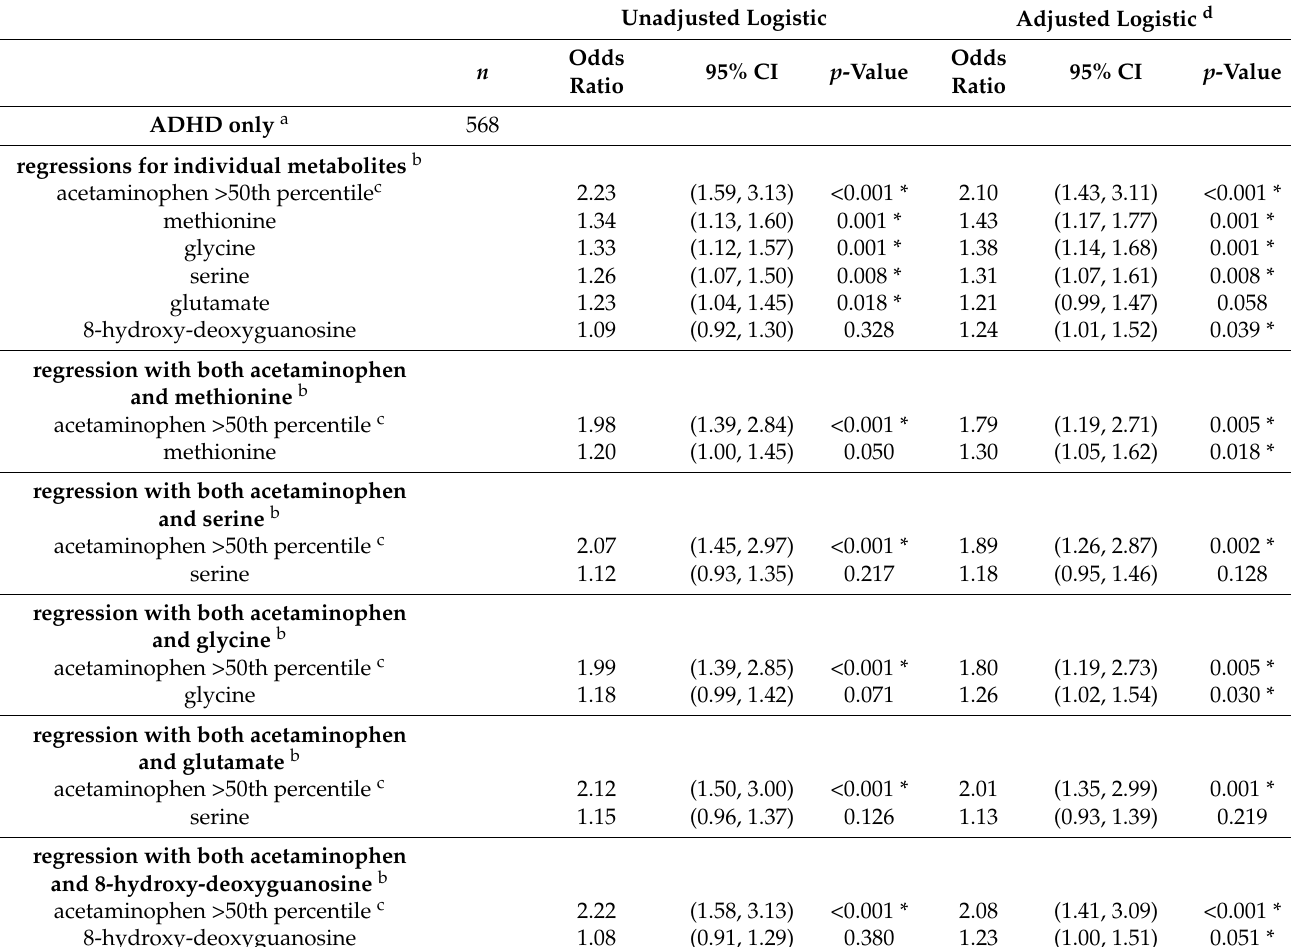
Table 2. Logistic regressions examining risk of childhood ADHD for cord plasma metabolites a . Unadjusted